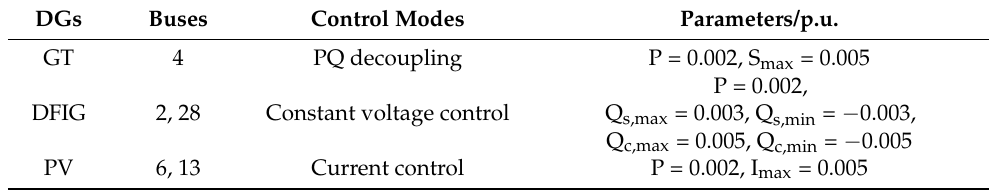
Table 1. Buses and parameters of the